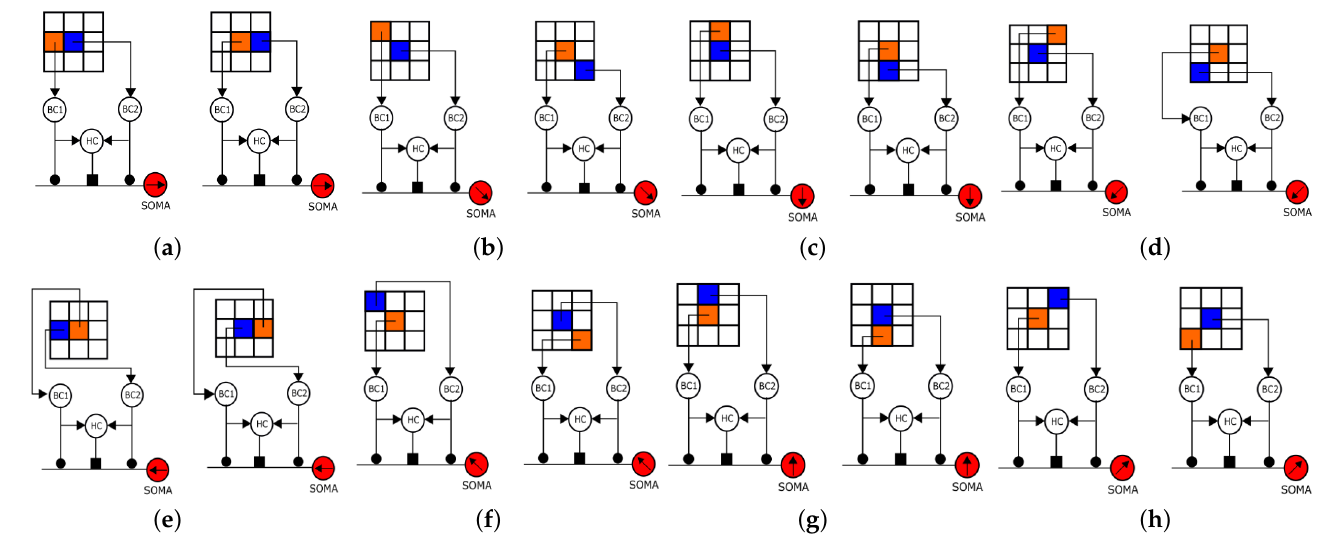
Figure 6. Eight types of LDNN responsible for eight different directions ( a – h ). The orange area represents the center pixel before the movement, and the blue area represents its position after the movement; only movements in the preferred direction will trigger the corresponding LDDN, and the triggered LDDN is shown in red in the